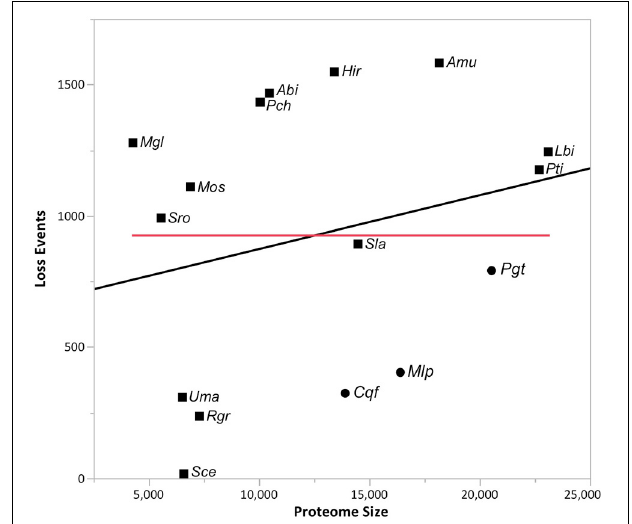
FIGURE 4 | The proteome size is positively correlated with the number of gene family duplications across taxa. The linear relationship ( R 2 = 0 . 93) between the proteome size (i.e., protein count) and the number of species-specific duplications detected in the analyses from Figure 1 is depicted in this figure. Rust pathogens ( Cqf , Mlp , and Pgt ) are indicated with circles and non-rust pathogens with squares. The line of best fit (black) is indicated. Please reference Methods for species abbreviations.